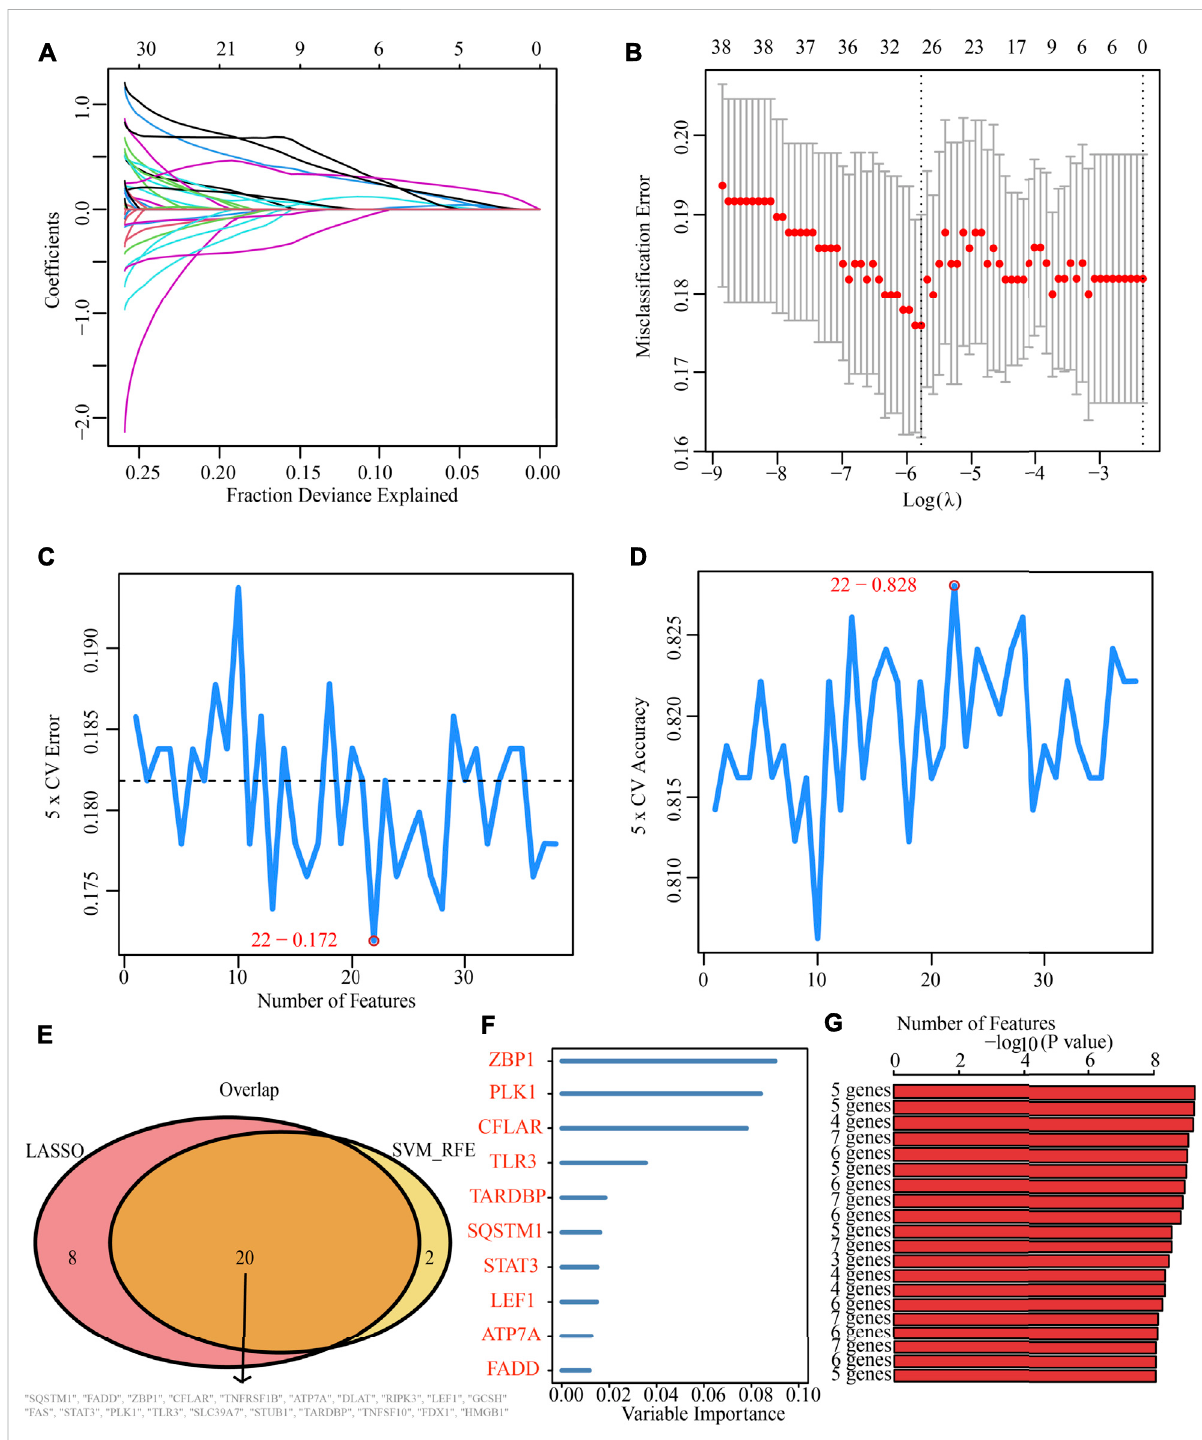
FIGURE 6 Machine learning identi fi cation of the optimal prognostic signature. (A,B) Identi fi cation of 28 CNRGs through the LASSO algorithm. (C,D) Identi fi cation of 22 CNRGs through the SVM-RFE algorithm. (E) Acquisition of 20 candidate CNRGs after intersecting LASSO and SVM-RFE algorithms. (F,G) Construction of a fi ve-CNRG signature through random survival forests-variable hunting (RSFVH)